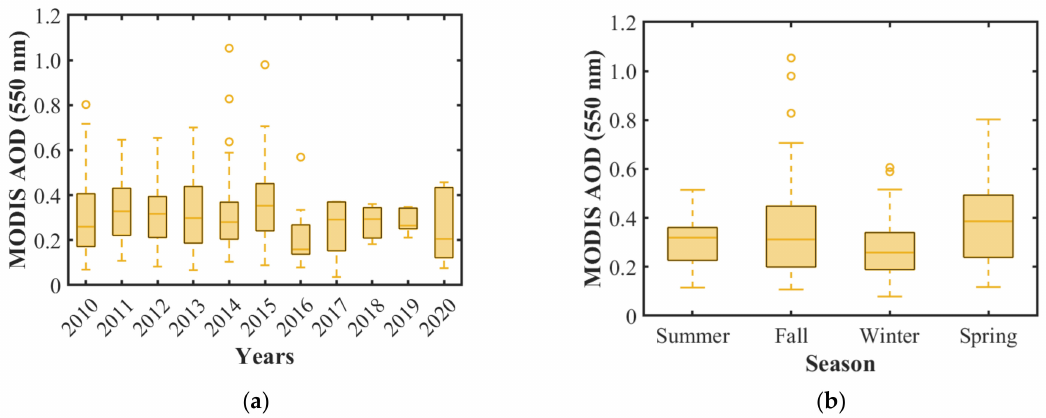
Figure 3. Boxplots of combined mean MODIS AOD values in the two study areas, Koronadal City and Quezon City: ( a ) annual and ( b )